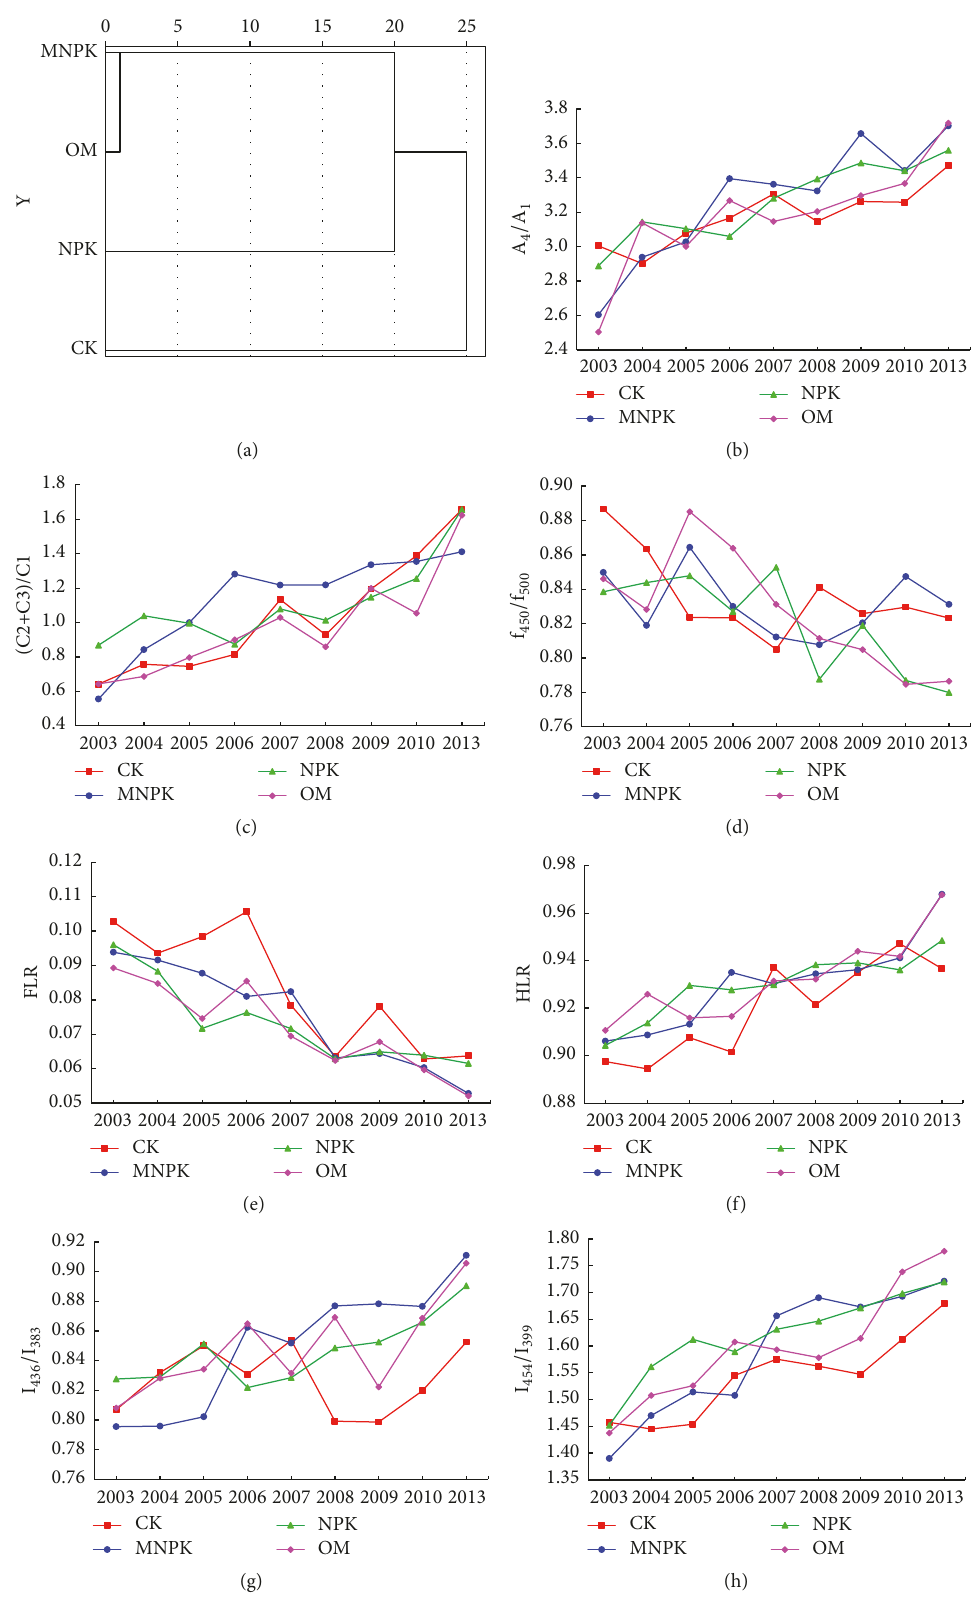
Figure 4: Clustering tree of the scores of the two principal components for all the field treatments (a) and the changes in humification indices ((b)–(h); see text for details). CK=control, NPK= NPK fertilizer, OM=organic manure, and MNPK=manure +